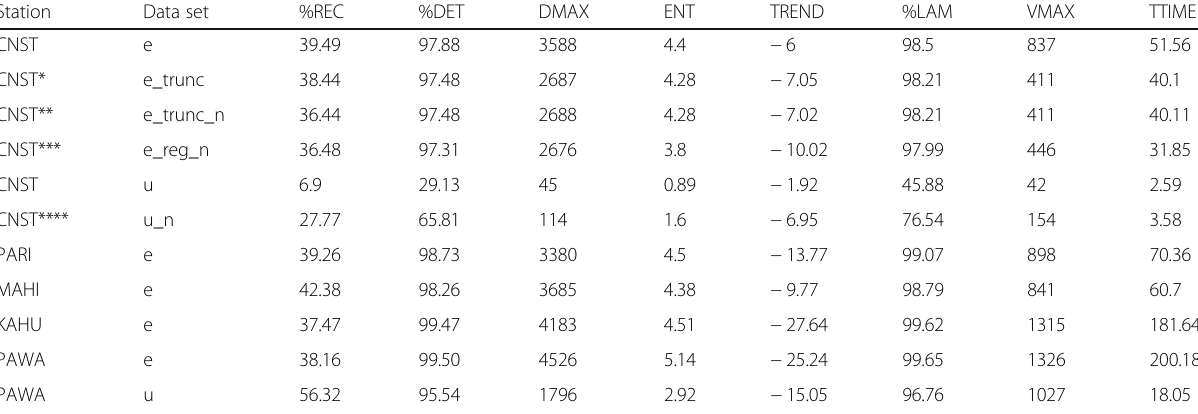
Table 3 RQA measures for selected GNSS data sets on the North Island of New Zealand